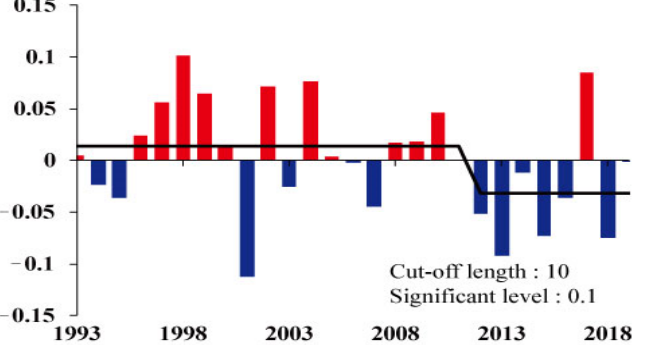
Figure 3. Long-term variations in the Kuroshio Current intensity in January. Black line represents step changes estimated using sequential t -test analysis of regime shifts analysis.